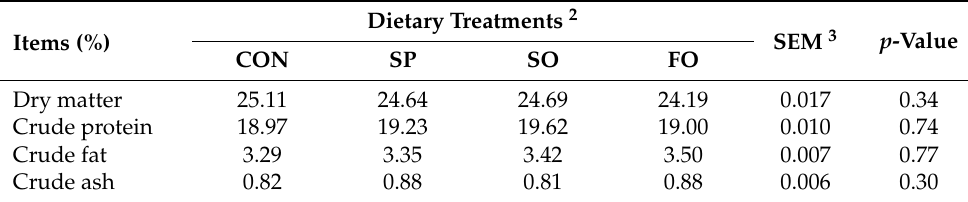
Table 6. Effects of dietary microalgae, salmon oil, and flaxseed oil on proximate composition of thigh meat in broiler chickens 1 .